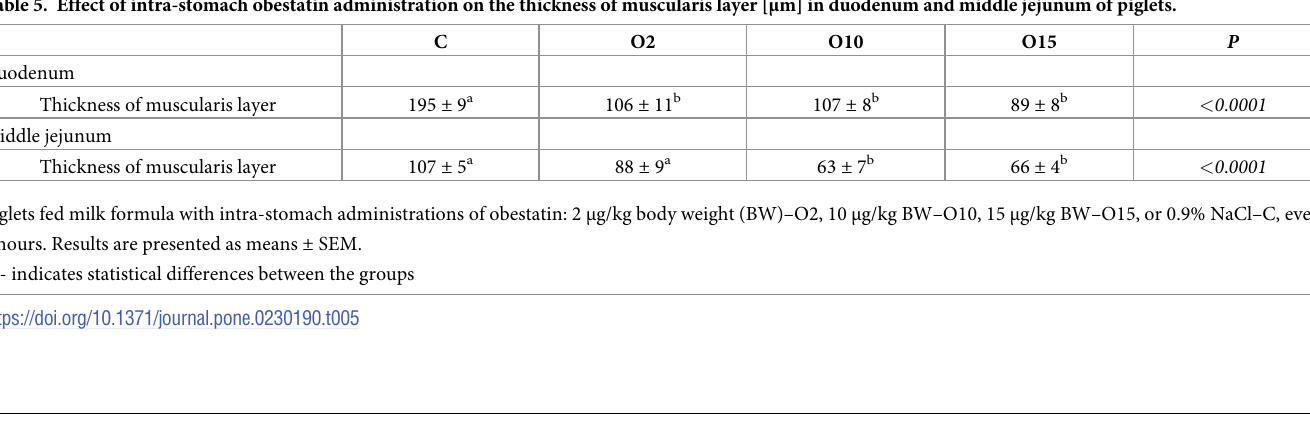
Piglets fed milk formula with intra-stomach administrations of obestatin: 2 μ g/kg body weight (BW)–O2; 10 μ g/kg BW–O10; 15 μ g/kg BW–O15, or 0.9% NaCl–C, every 8 hours. Results are presented as means ± SEM. a,b - indicates statistical differences between groups.